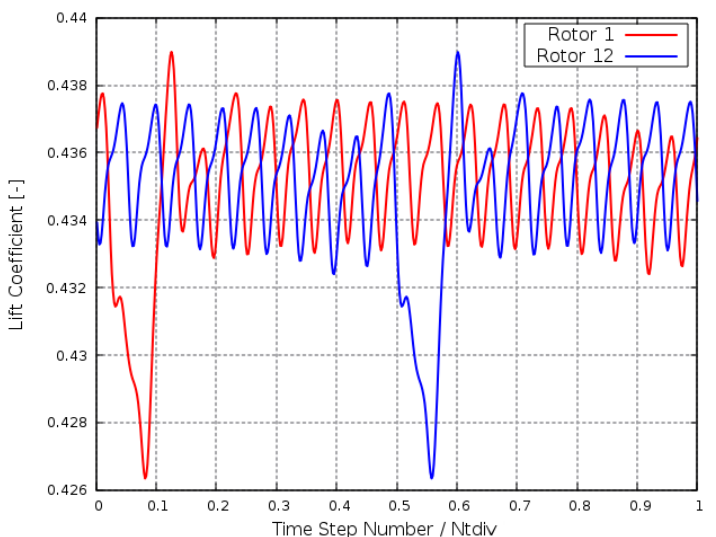
Figure 9. Unsteady lift coefficient for two different rotor profiles during 1/7 of the rotor revolution. The instantaneous entropy contours on a blade-to-blade surface are shown in Figure 10 to highlight the typical interaction between adjacent rows due to the wakes. The IGV wake passes through the stator and impinges the rotor blades, adding to the stator wake distortion (EO = 126) a further distortion with EO = 7. This causes the single highest peak in the lift coefficient shown in Figure